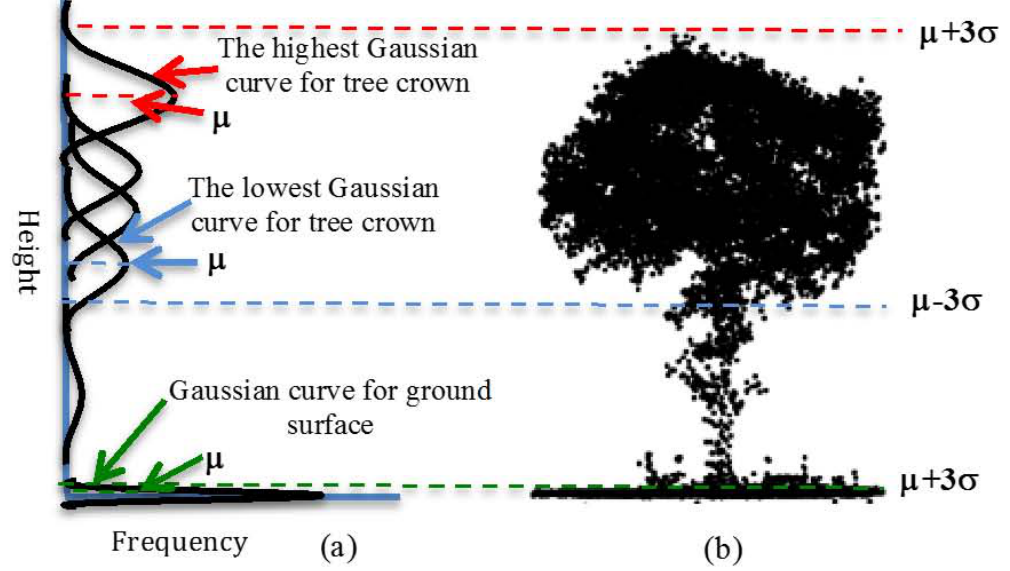
Figure 6. ( a ) Histogram for elevation value of point clouds fitted with multiple Gaussian models and ( b ) the corresponding point clouds of a single tree